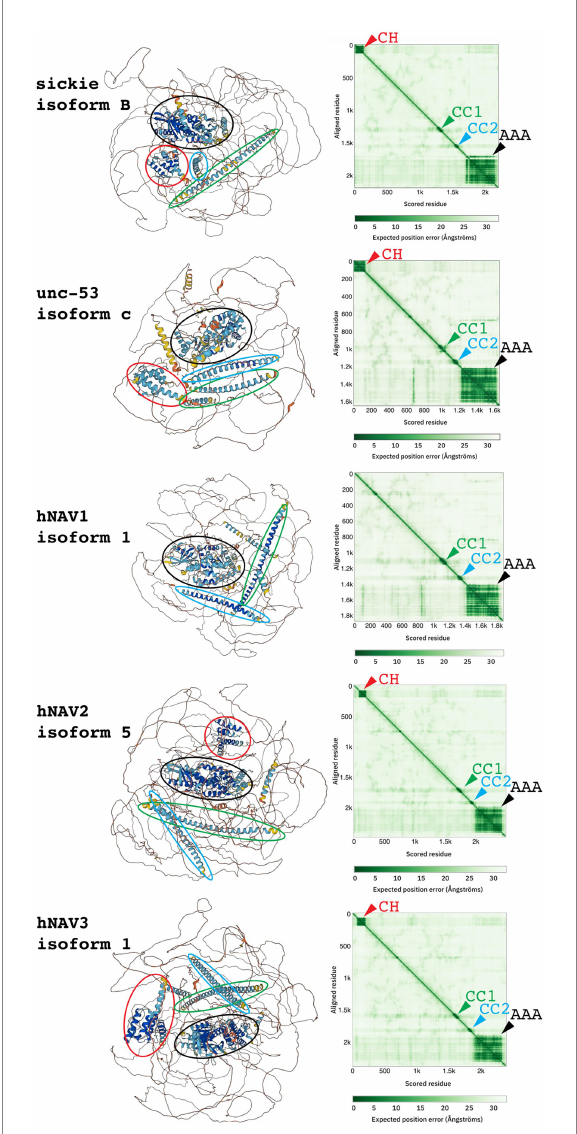
FIGURE 2 Three-dimensional structures (left) and predicted aligned error graphs (right) for indicated NAV family proteins. In each protein, four domains (CH, CC1, CC2, and AAA+) were identified, as indicated by colored ovals encompassing predicted structures, and matching color arrowheads on graphs. Between the four domains, structure predictions were low